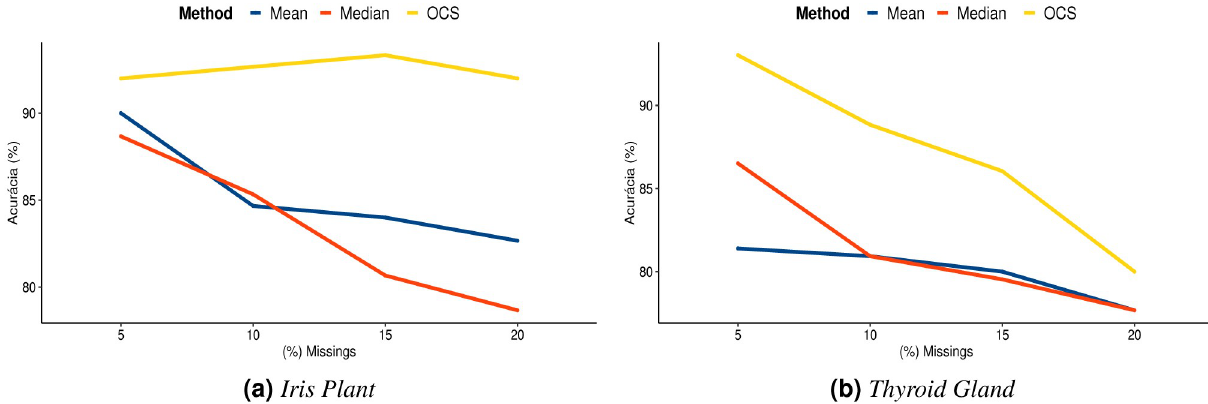
Fig 8. Performance graphs of the methods for different percentages of missing values. ( a ) Iris Plant . ( b ) Thyroid Gland .